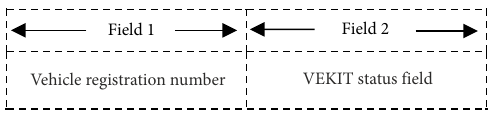
Figure 7. VEKIT front end software screenshot showing VEKIT status